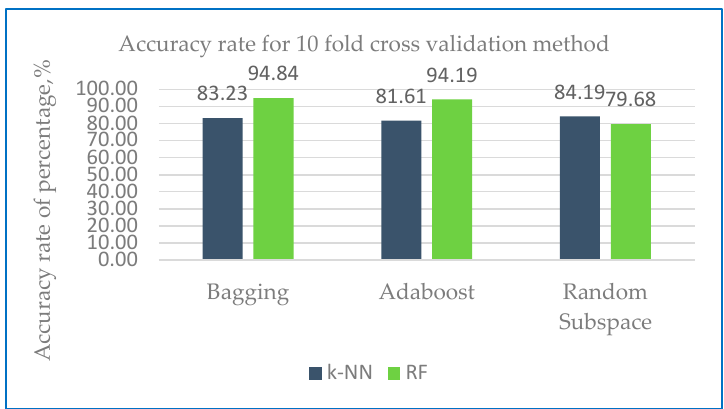
Figure 18. Accuracy rate of Dataset 2 with 10-fold cross validation method. Sensors 2020 , 20 , x FOR PEER REVIEW